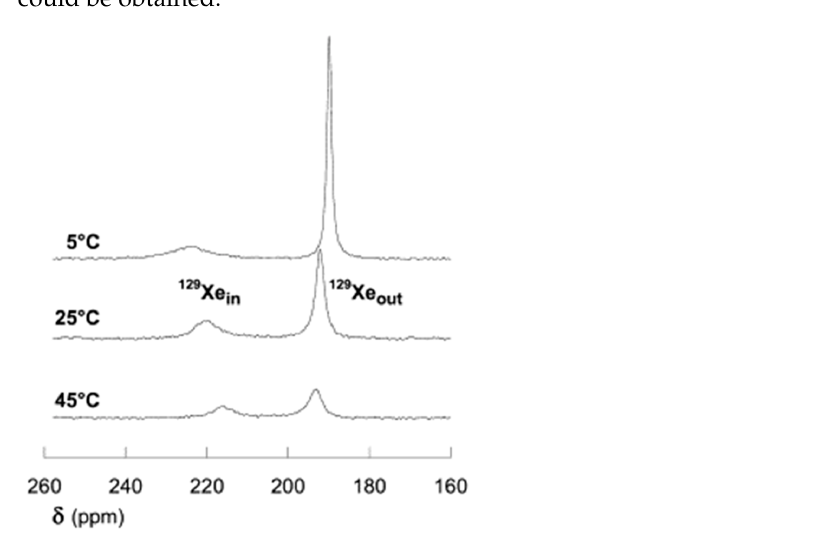
Figure 6. Variable temperature 129 Xe NMR spectra of xenon dissolved in a polystyrene colloid below the glass transition temperature ( T g = 107 °C). Reprinted with permission from reference [92]. Cop ‐ yright 2006 Journal of Colloid and Interface Science .